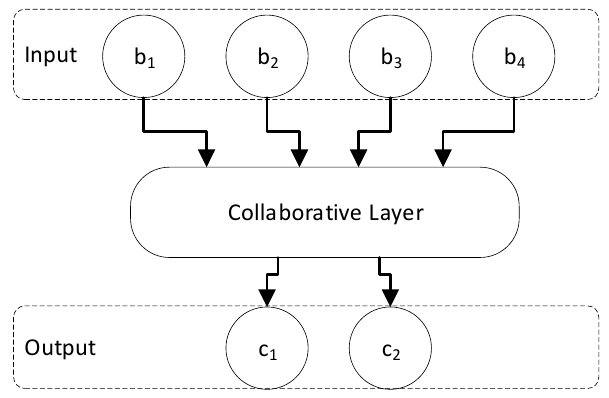
Figure 5. Structure diagram of the collaborative layer .